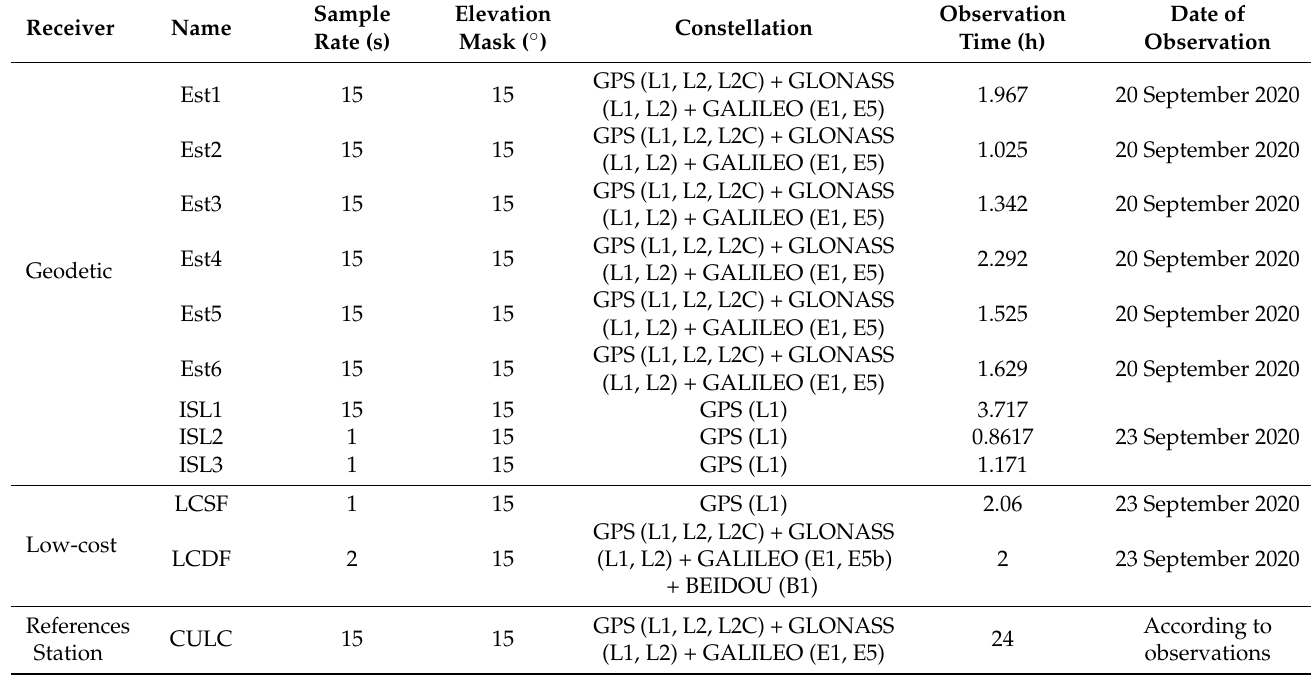
Table 3. Characteristics of the GNSS